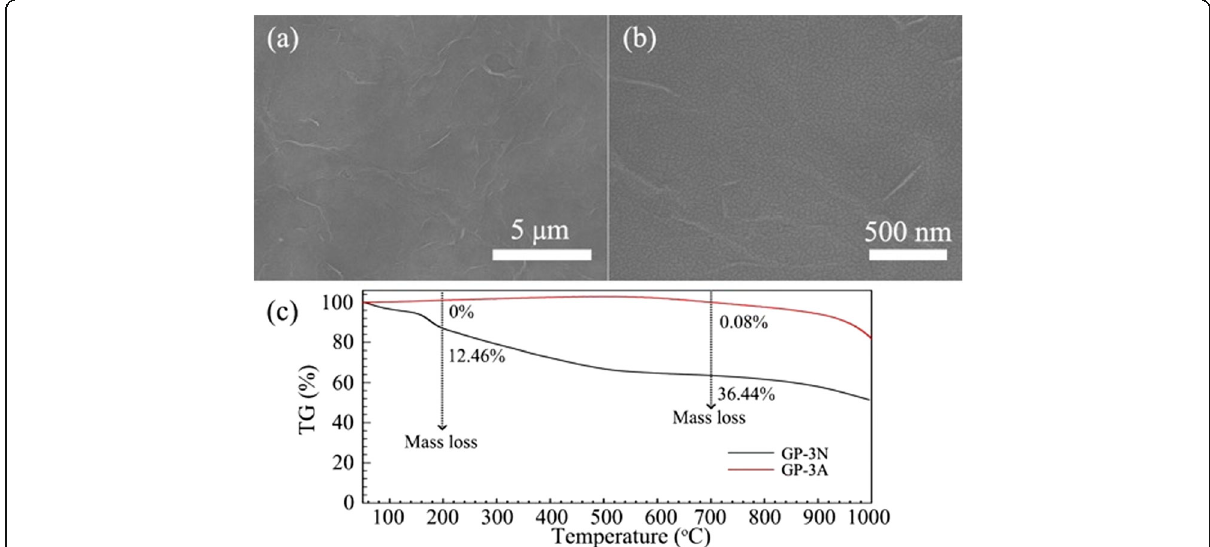
Fig. 5 a , b SEM images of GP-3 graphene paper substrate with different magnifications. c The TGA results of the GP-3 graphene papers with (GP- 3A) and without (GP-3N) post annealing treatment